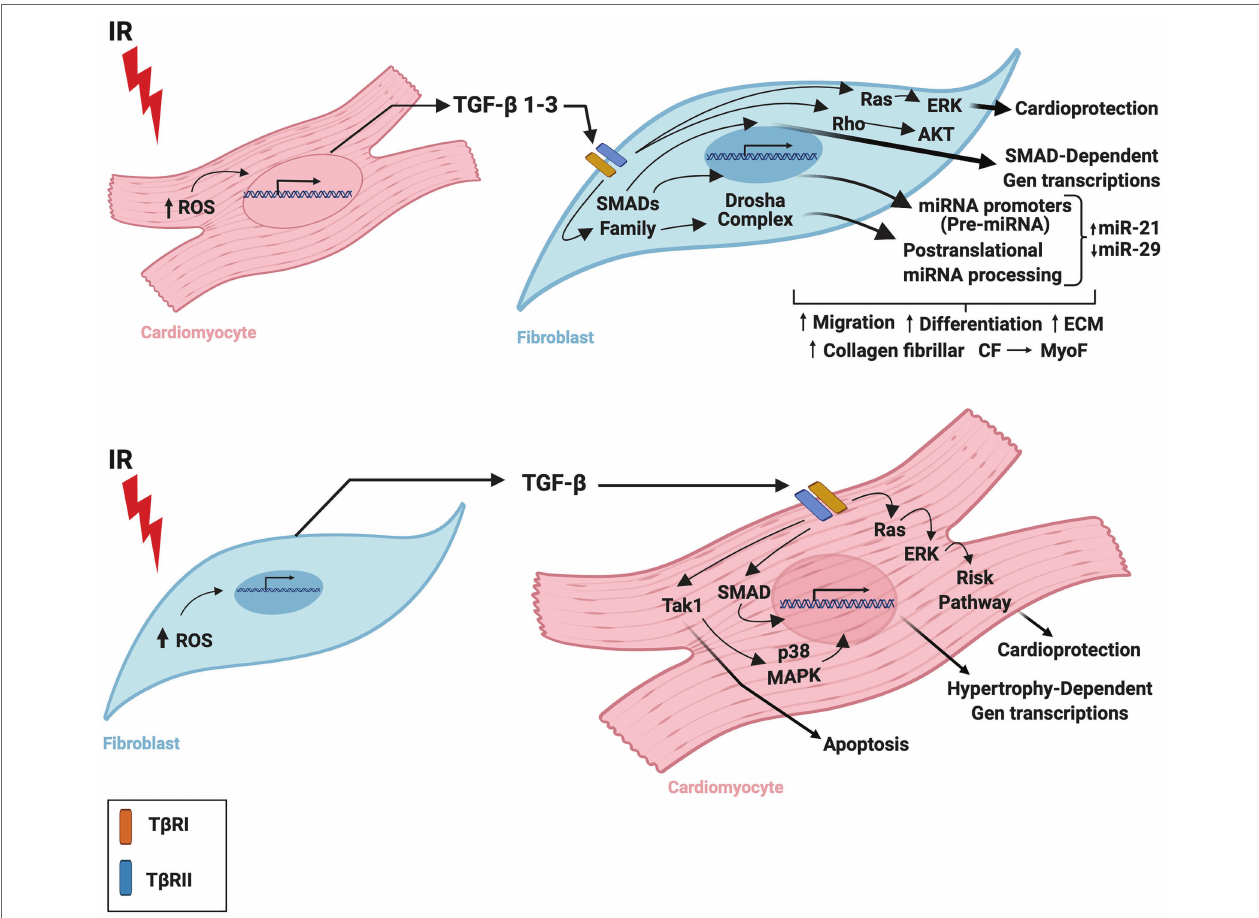
FIGURE 1 | Role of TGF- β in the crosstalk between cardiomyocytes and fibroblasts during ischemia/reperfusion. TGF- β is secreted by cardiac fibroblasts and cardiomyocytes during ischemia-reperfusion inducing cardiac repair and remodeling. TGF- β is required for cardiac fibroblast differentiation and cardiomyocyte hypertrophy. IR, ischemia/reperfusion; TGF- β , transforming growth factor beta; ROS, reactive oxygen species; T β RI, transforming growth factor beta receptor I; T β RII, transforming growth factor beta receptor II; CM, cardiomyocytes; CF, cardiac fibroblasts; MyoF, myofibroblast. The figure was created using